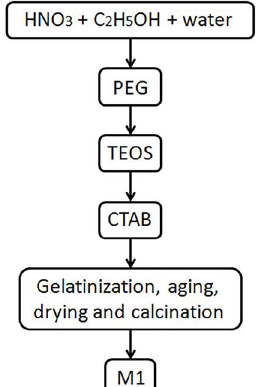
Figure 1. Steps involved in the preparation of silica monolith M1.